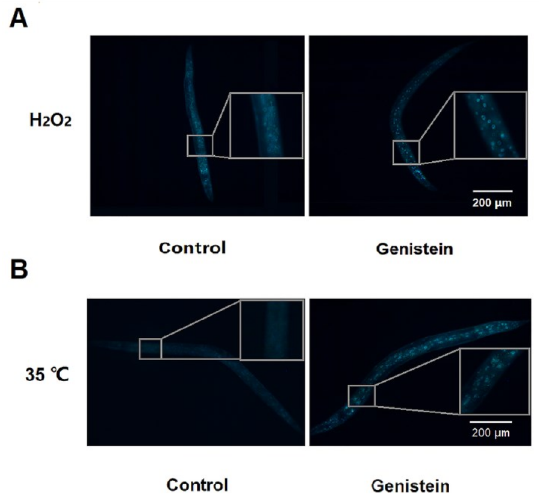
Figure 5. The effect of 200 µ M genistein on the nuclear localization of DAF-16::GFP in the stage L4 C. elegans under H 2 O 2 and 35 ◦ C conditions for one hour. ( A ) The effect of genistein on the nuclear localization of DAF-16::GFP in C. elegans exposed to H 2 O 2 -induced oxidation. ( B ) The